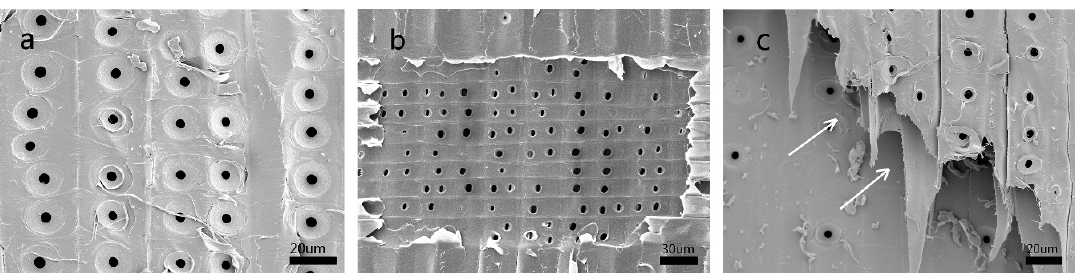
Figure 5. SEM micrographs of cracks between ray parenchyma cells and longitudinal tracheids under different MW intensities: ( a ) Control, ( b ) low ‐ intensity, ( c ) high ‐ intensity.